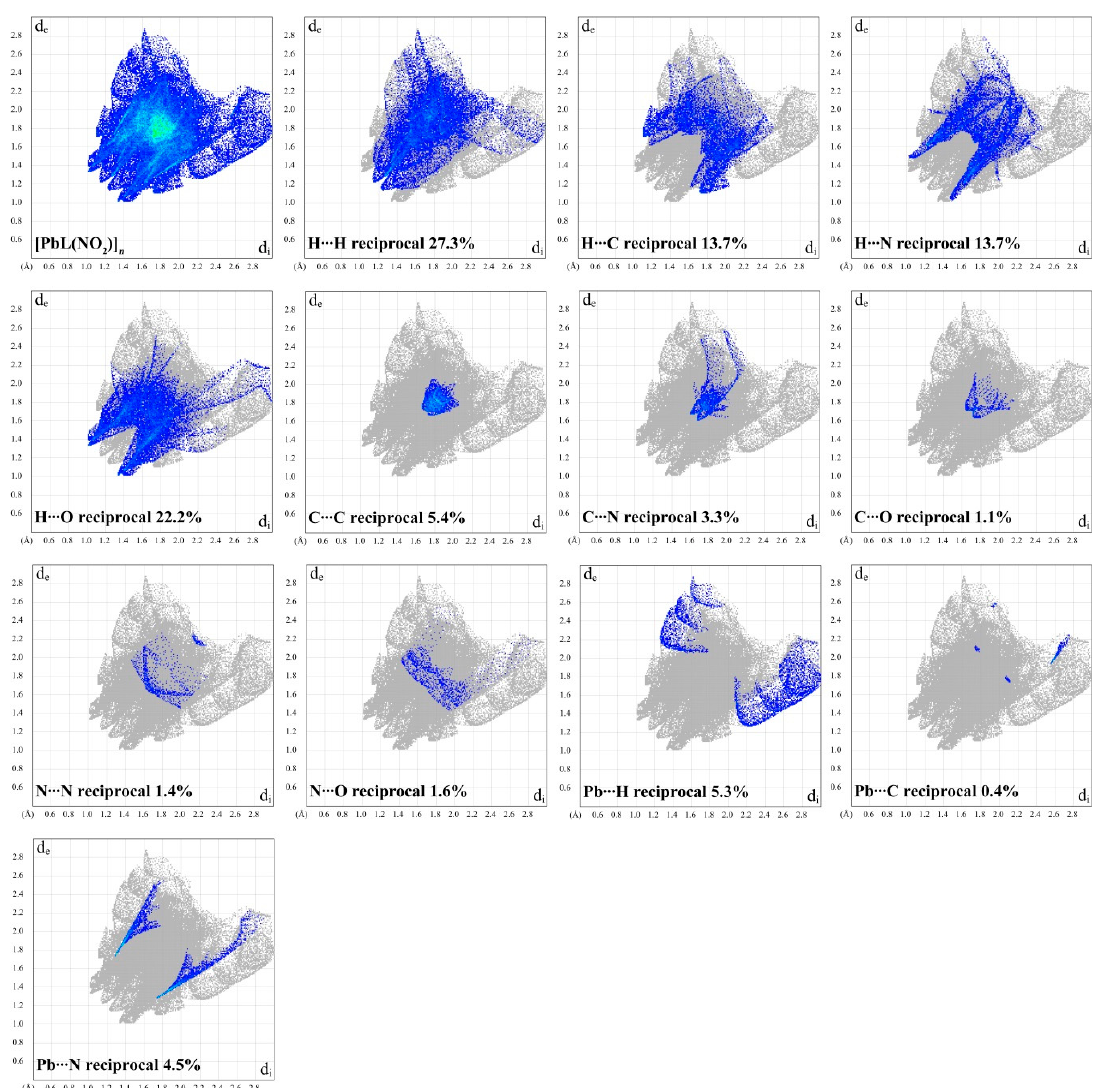
Figure 4. Two-dimensional and decomposed 2D fingerprint plots of observed contacts for [PbL(NO 2 )] n . The d i value is the distance from the surface to the nearest atom interior to the surface, and d e is the distance from the surface to the nearest atom exterior to the surface. Color code: blue = a fraction of the surface points of the corresponding contact.